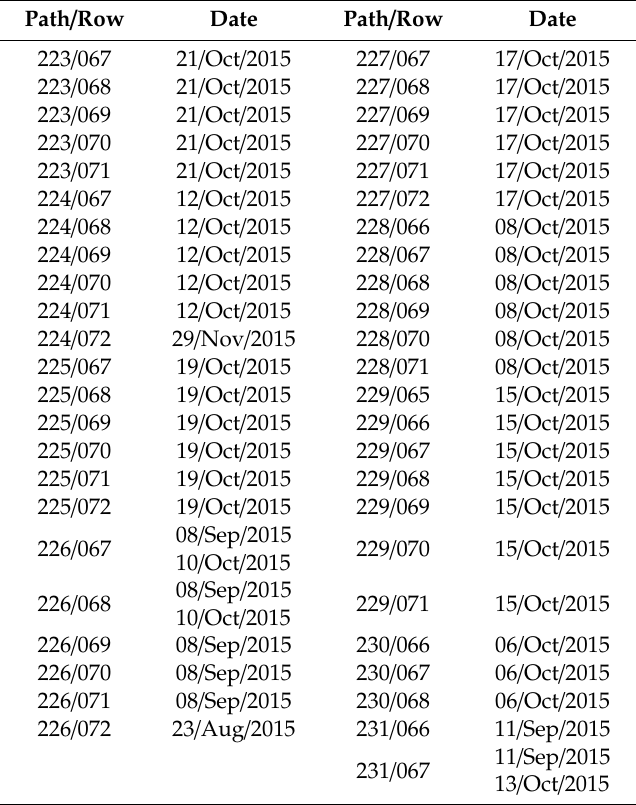
Table A1. Landsat OLI images (path / row and dates) used in this study. Path /